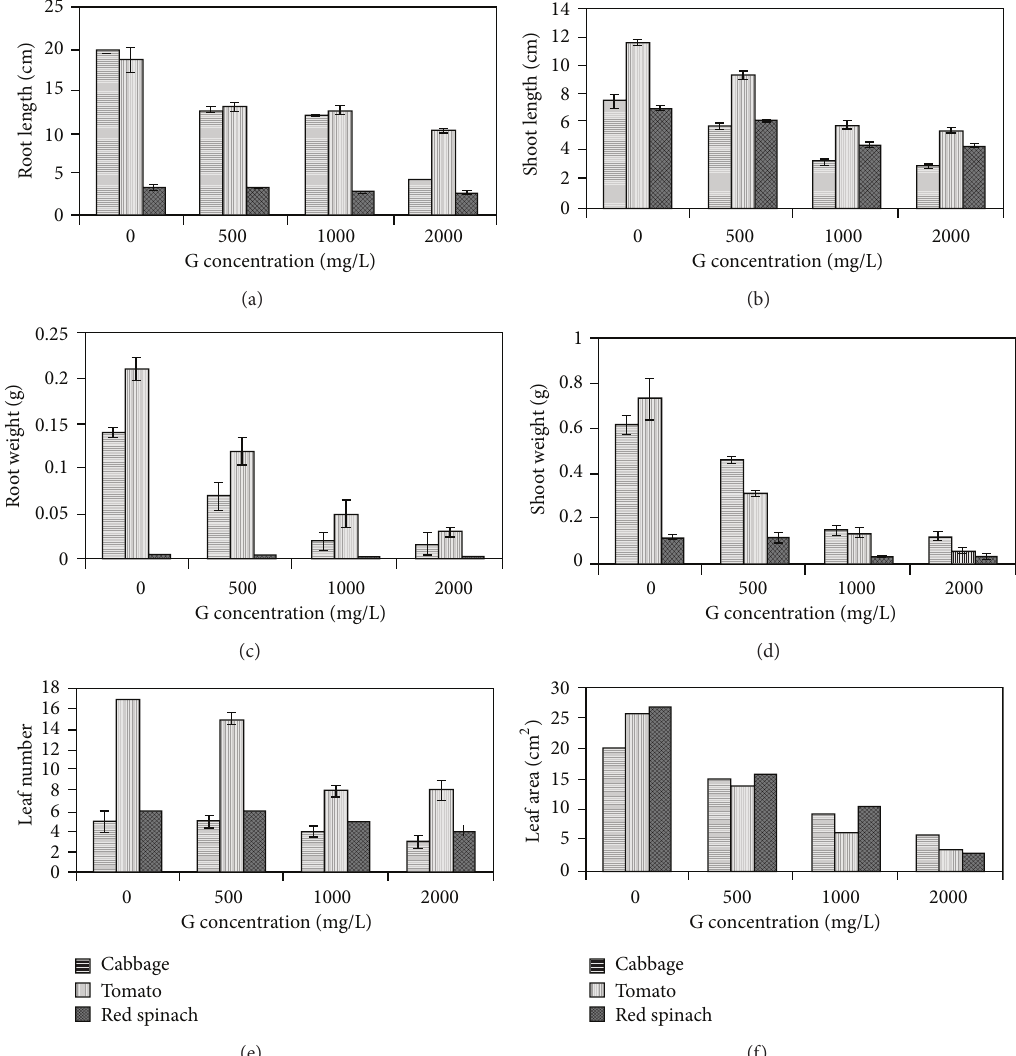
Figure5:Effectofgraphene(G)onofredspinach,cabbage,andtomatoseedlings.21daysseedlingsgrowthonHoaglandmediawithgraphene (0, 500, 1000, and 2000 mgL −1 ) were utilized for all measurements. (a) Root length, (b) shoot length, (c) root weight, (d) shoot weight, (e) leaf number, and (f) leaf area